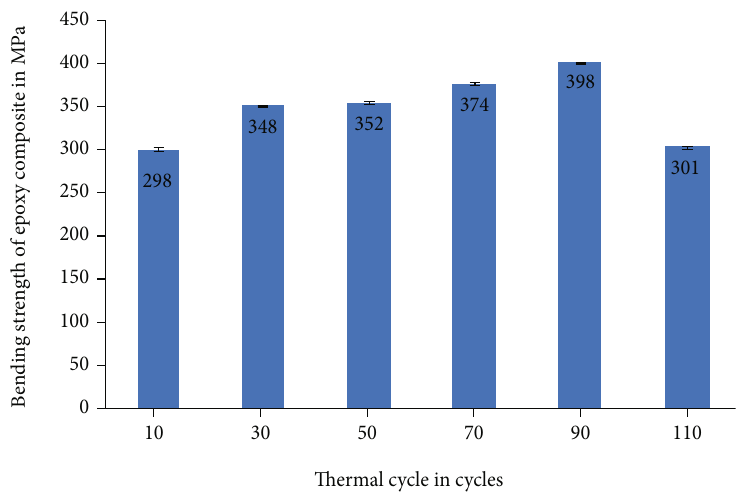
Figure 8: Bending strength of epoxy composite with di ff erent thermal Figure 6 indicates basalt fi ber ’ s e ff ect on the composite ’ s